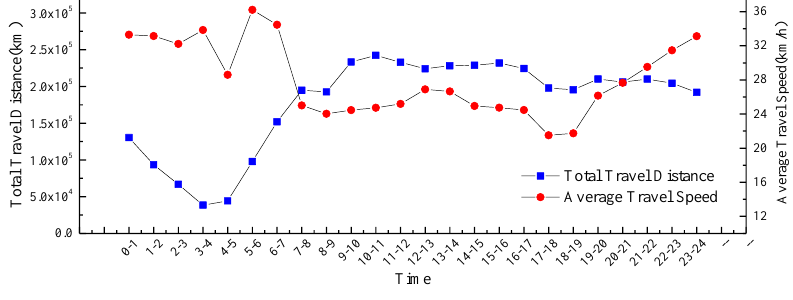
Figure 11. Average travel speed and total travel distance during one day.